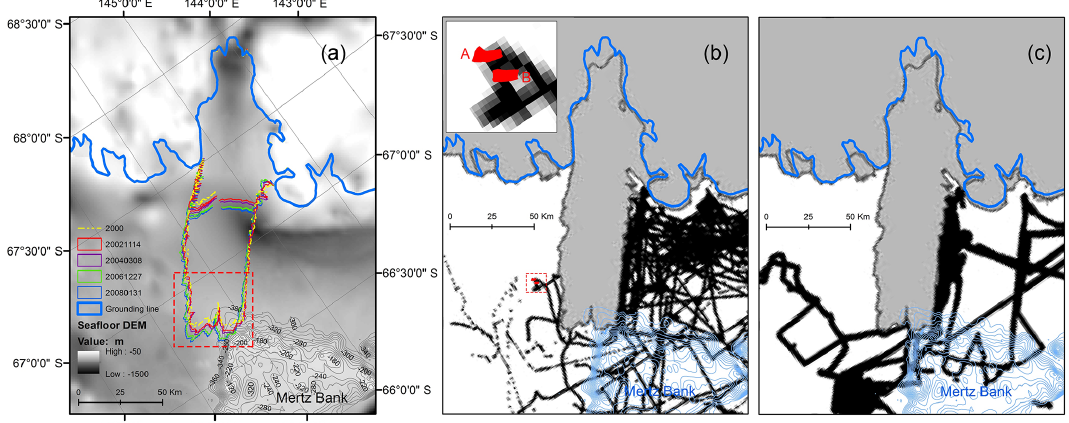
Figure 3. (a) Seafloor topography from bathymetry around Mertz and the outlines of the MIT from 2002 to 2008 marked with the colored polygons for different years. The shallow Mertz Bank is located in the lower right (northeast). The yellow dash-dotted line indicates the shape of the MIT from 25 January 2000, which is used to identify the bathymetry gap under the ice tongue. The dashed red inset box corresponds to the location of Figs. 6 and 7. (b) Multi-beam bathymetry data set coverage over the Mertz region. The embedded figure in the upper left is the zoom in of the dashed red rectangle which shows the positions of icebergs A and B (polygon filled in red) on 19 February 2008 (Fig. 4b). (c) Single-beam bathymetry data set coverage over the Mertz region. The light blue polylines show the contours around the Mertz Bank and the black dots are bathymetric measurement profiles. Both (b) and (c) are redrawn from Beaman et al. (2011) because the original spatial coverage of the single and multi-beam bathymetry data are not available. However, for being able to use the figures from Beaman et al. (2011), we geo-registered it and put the contour around the Mertz Bank and the location of icebergs used in the text over it which illustrates the density of the bathymetry measurements. Through comparing the grounding lines from (b) and (c) , we can conclude that the geo-registration is successful as the grounding line we obtained from the National Snow and Ice Data Center (NSIDC) coincides with that from Beaman et al. (2011) well in most parts. This figure is under a projection of polar stereographic projection with − 71 ◦ S as standard latitude.